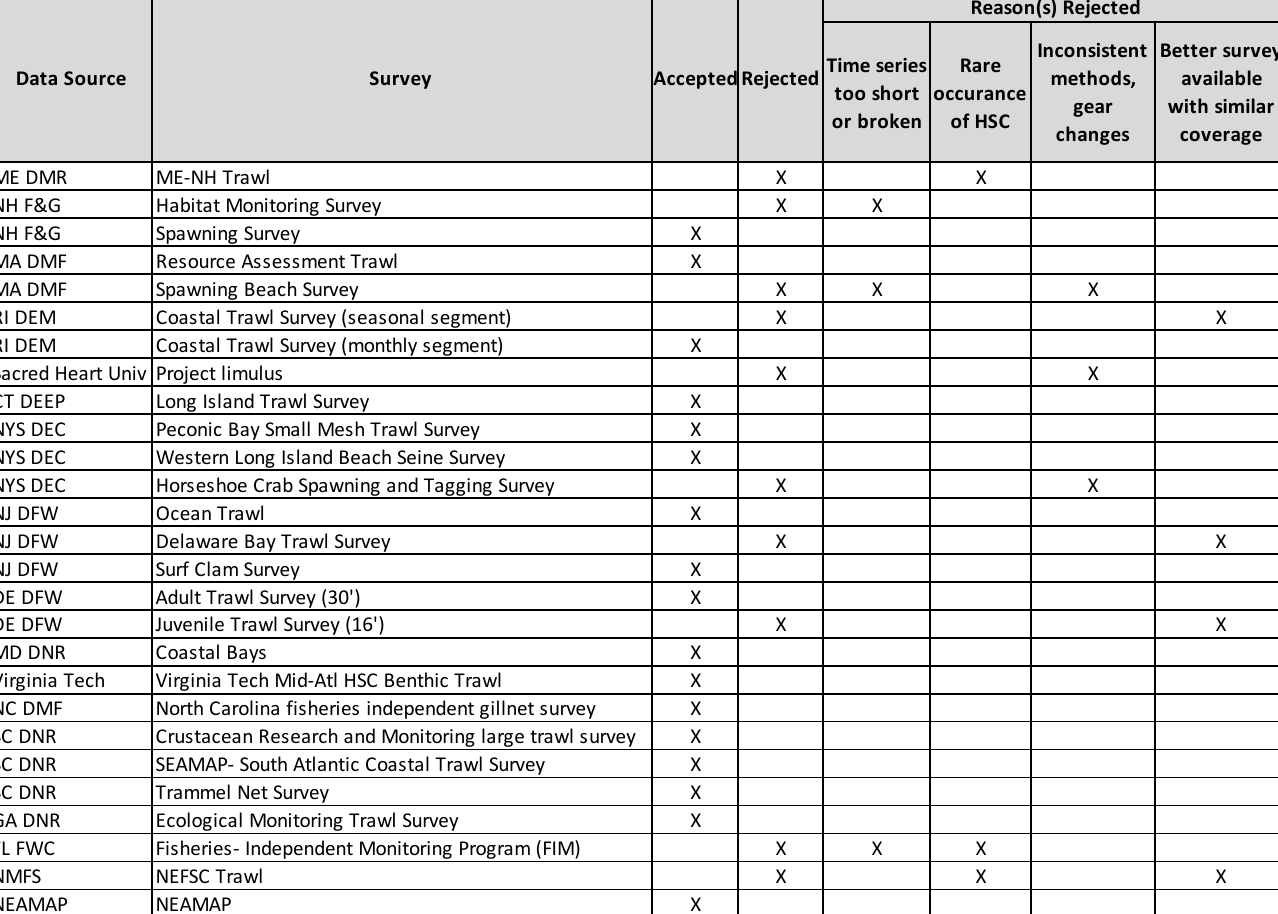
Table 33. Surveys considered for developing abundance indices for horseshoe crab. Table indicates which surveys were accepted for index development and which were